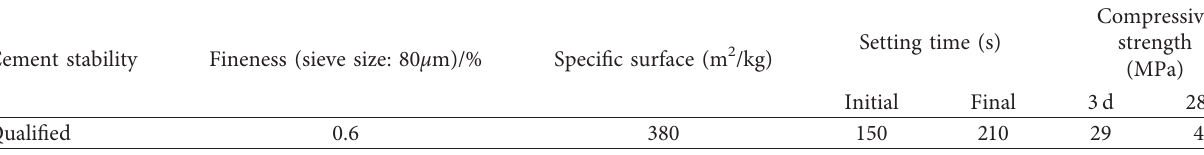
Table 1: Basic properties of cement.